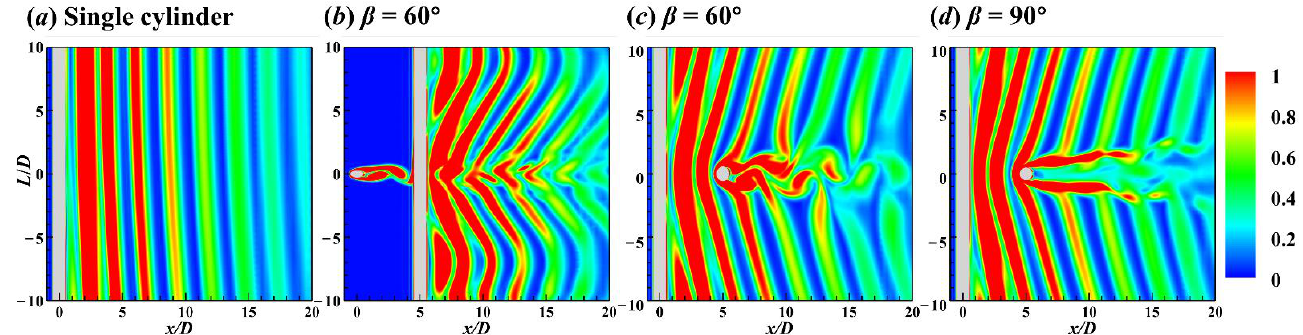
Figure 8. Contours of instantaneous vorticity magnitude on the xy plane for the flow around the single ( a ) and two crossing cylinders in 60° ( b , c ) and 90° ( d ) arrangements. The angle between the plane shown in ( b ) and xy plane is 60°, and the plane is parallel to DC in 60° arrangement. The vorticity is normalized by U ∞ / D .